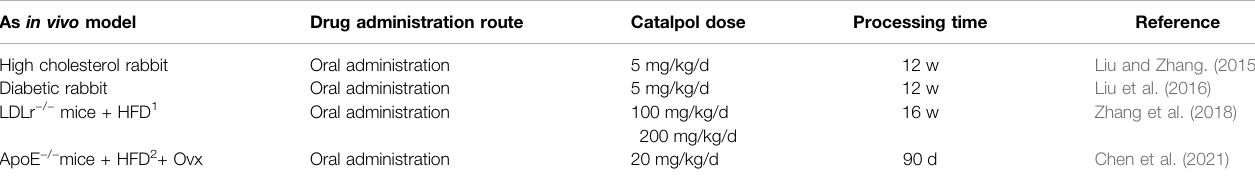
TABLE 1 | Different animal models have been used to prove that catalpol improves AS. As in vivo